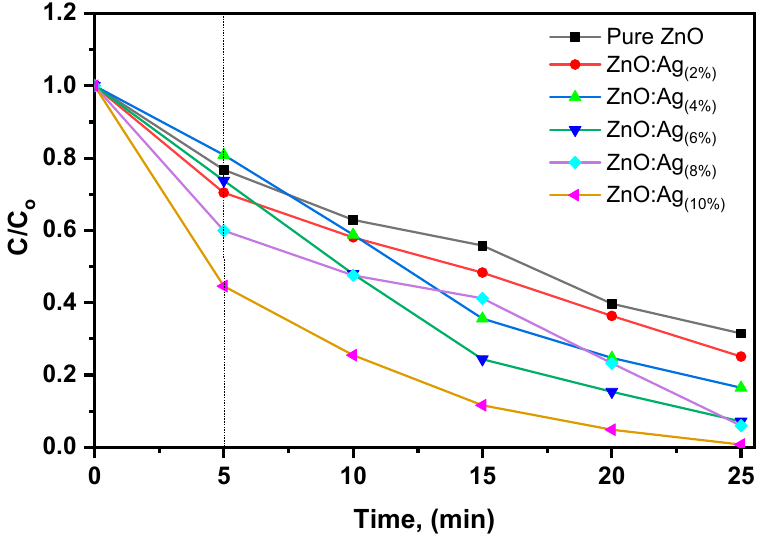
Figure 11. Concentration spectra of MB using pure and Ag-doped ZnO submicron structures as a catalyst.